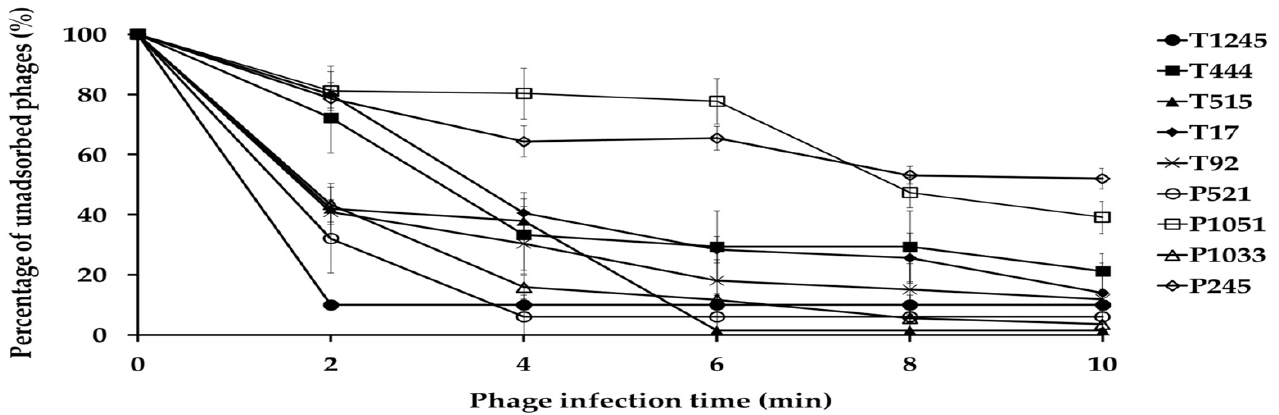
Figure 3. Adsorption of nine phages to their primary bacterial hosts. The free phage proportion was the amount of non-adsorbed phage to the amount of phage used for infection. Three independent experiments were performed in triplicate and error bars represent the standard deviation.